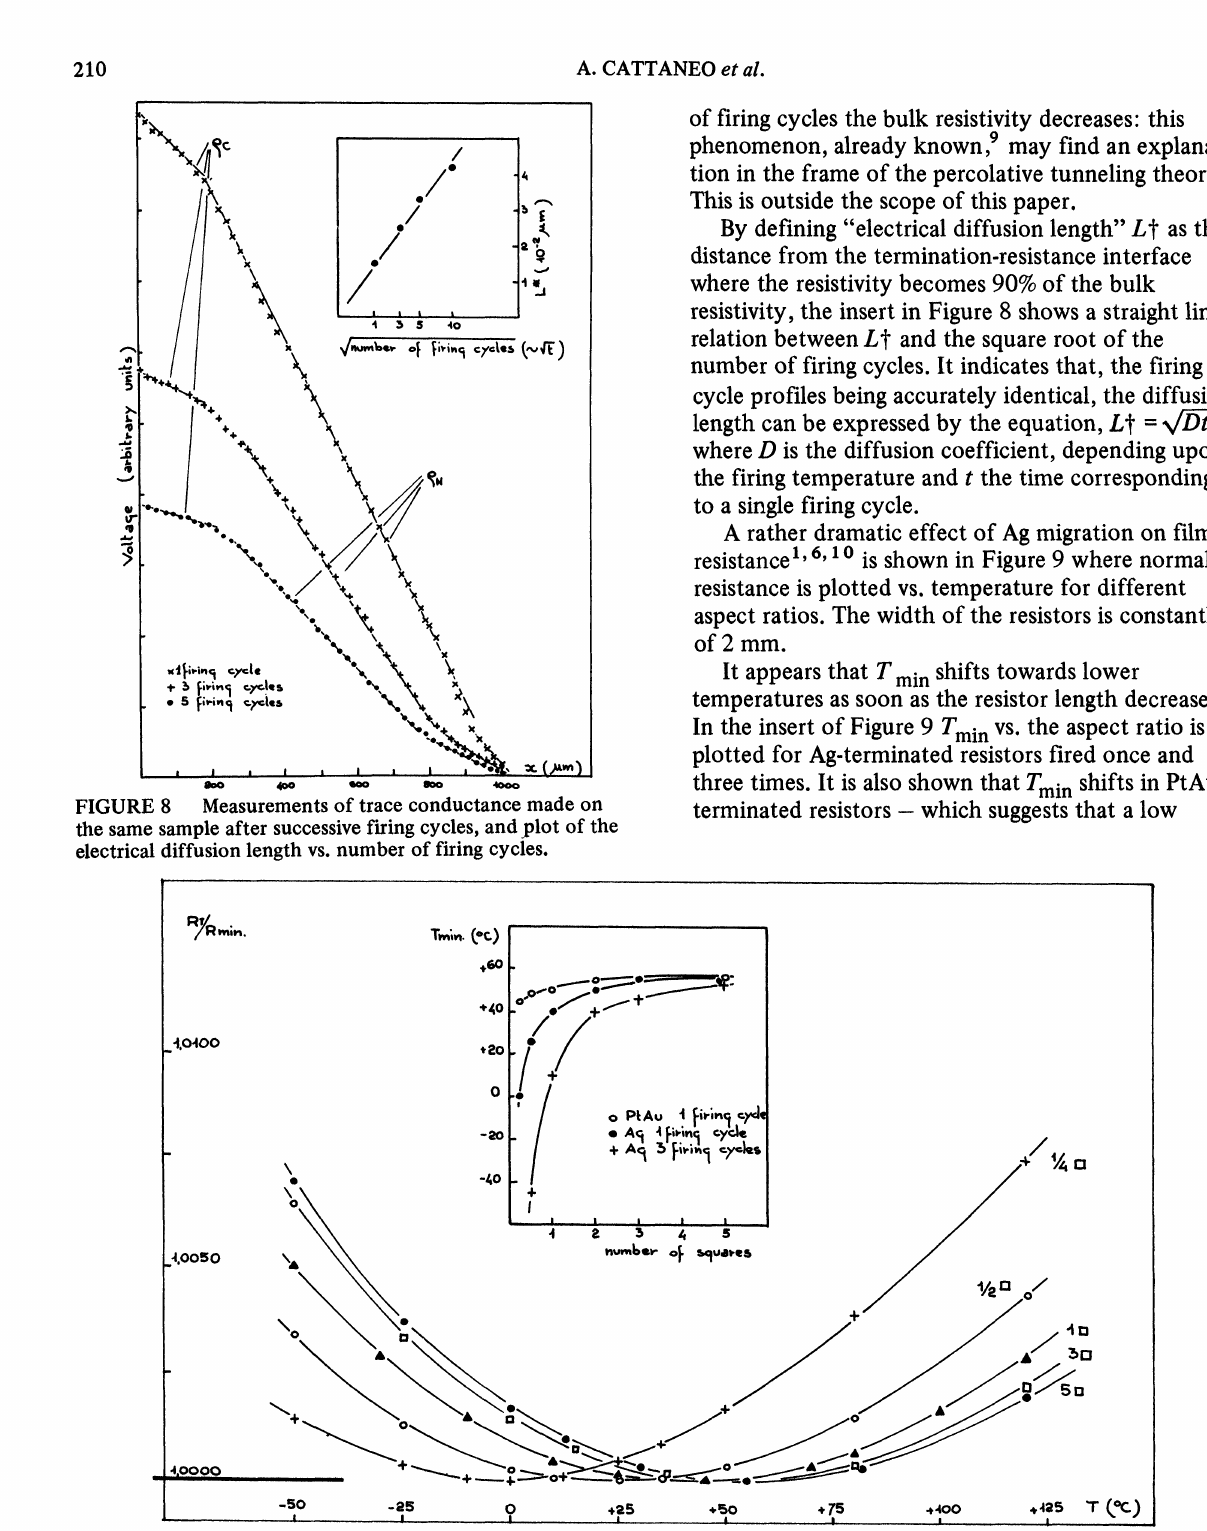
Normalised resistance vs. temperature for resistors with different aspect ratios and influence of the aspect ratio on